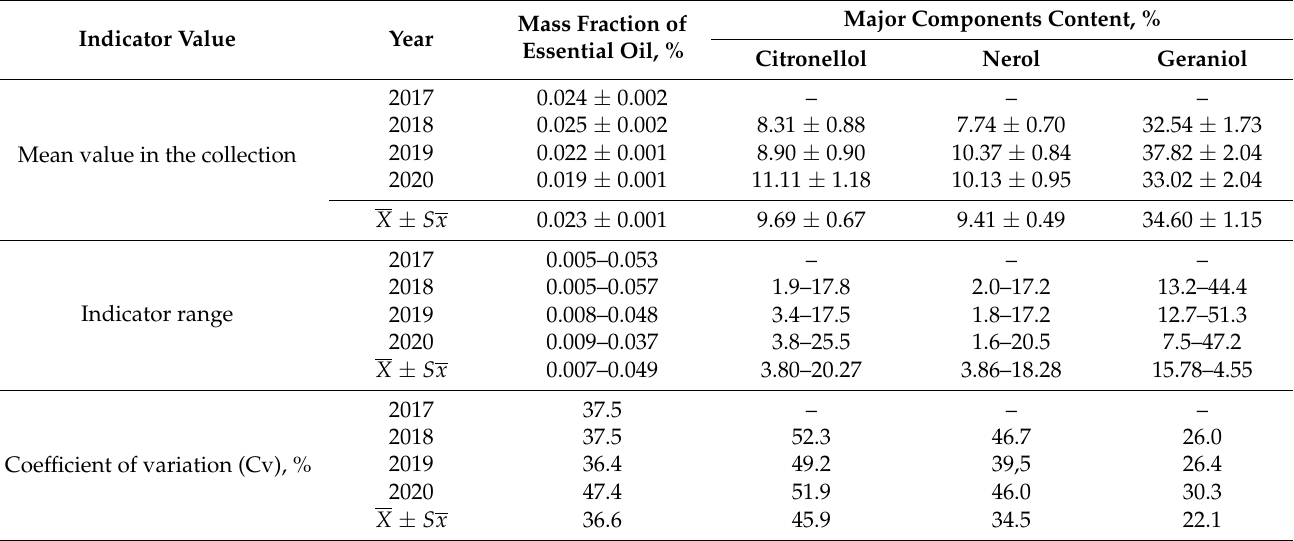
Table 1. Characteristics of the essential-oil-bearing rose collection in terms of the essential oil content and the major components ratio,